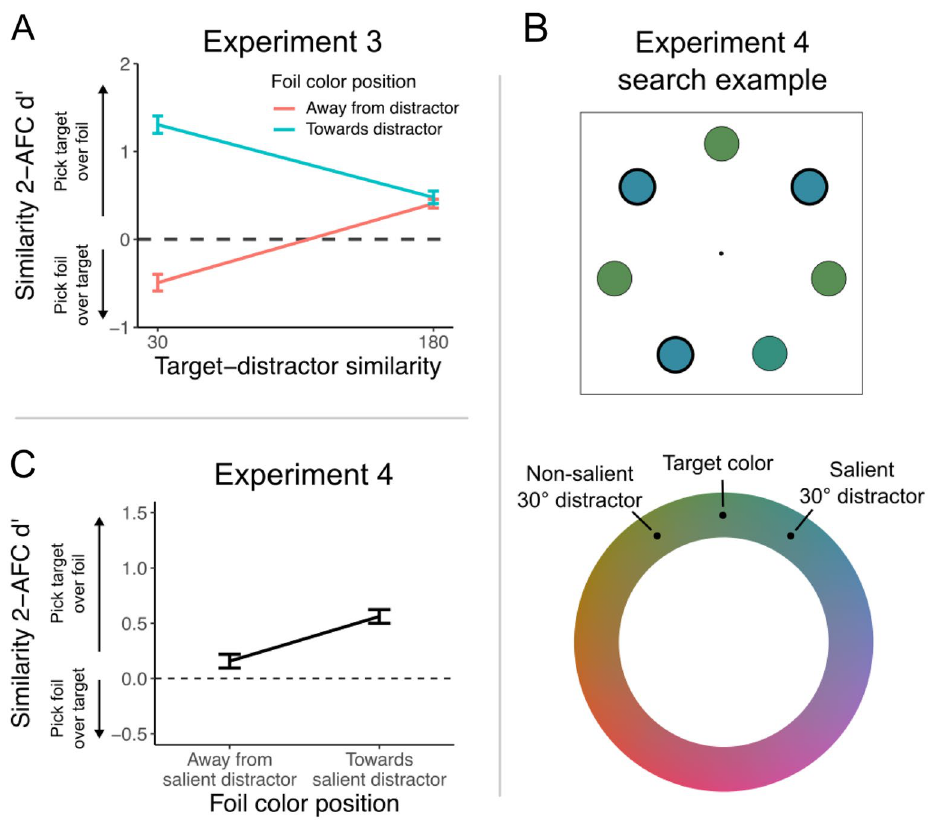
Figure 2. ( A ) Results from Experiment 3, where there was no delay between the search array and similarity judgment. Color judgment performance in the 2AFC task was comparable to Experiment 1 for 30° target- distractor similarity during search. ( B ) Example of a visual search trial in Experiment 4. Participants searched for an oddball target color (bottom right in this example) among distractors that were evenly chosen 30° clockwise and counterclockwise relative to the target. One distractor color was made more salient by increasing the thickness of its border. ( C ) Results from Experiment 4, where we manipulated the salience of distractors from one direction around the color wheel. Perception of the target color was more strongly biased by the salient